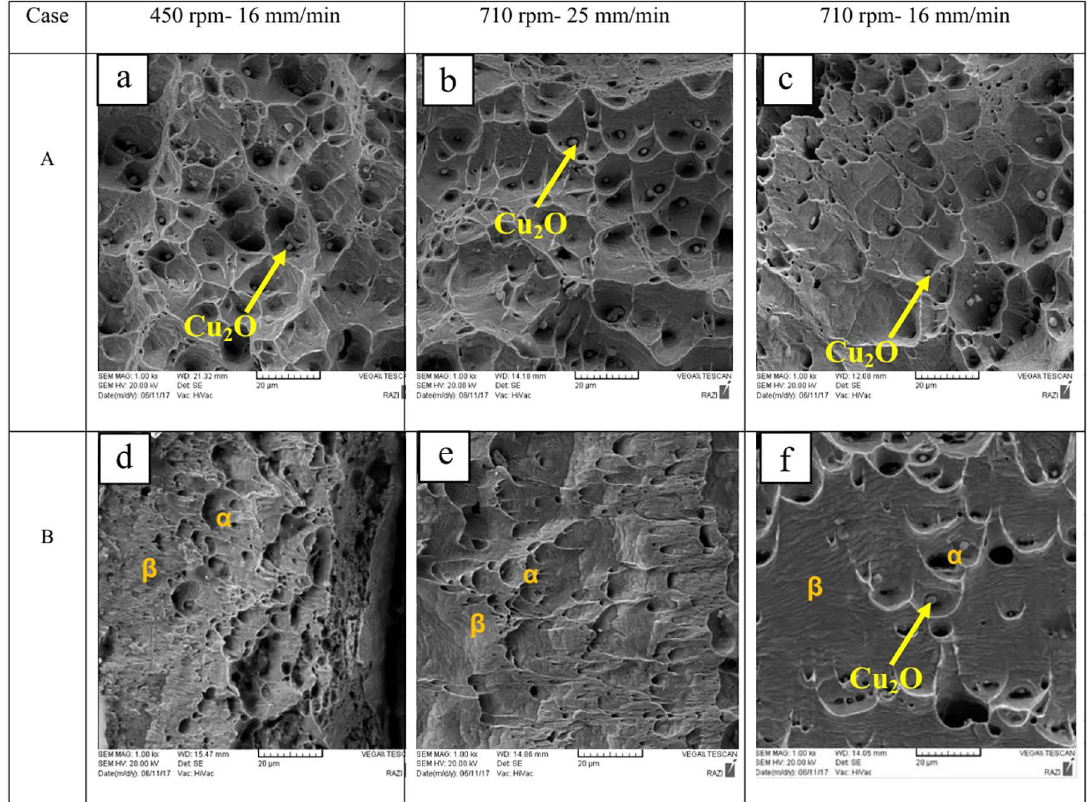
Figure 12. SEM fractographs of fractured tensile specimen.